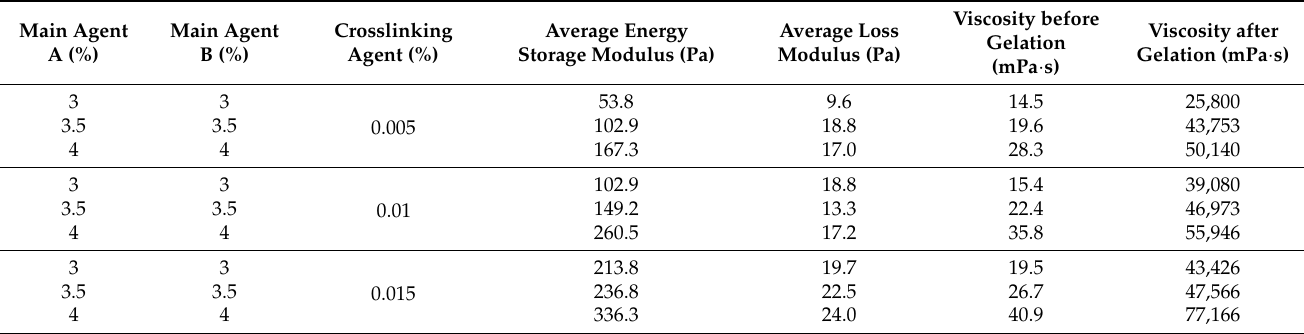
Table 2. The strength of the channel plugging system at different concentrations of main agent and cross-linking agent.